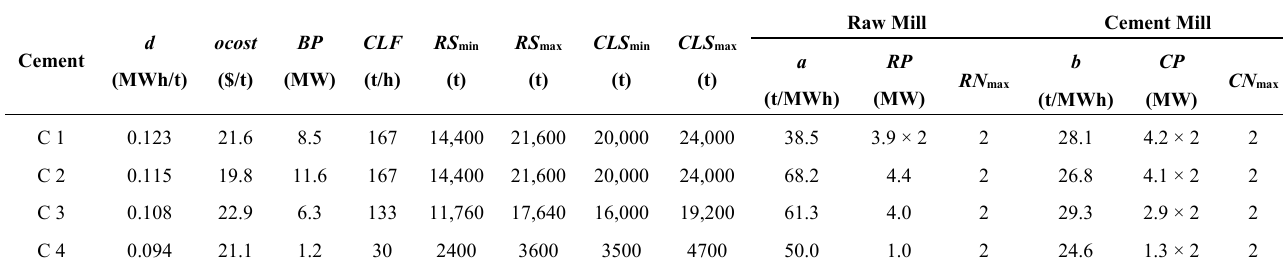
Table 4. Cement agent parameters for the provision of AS.